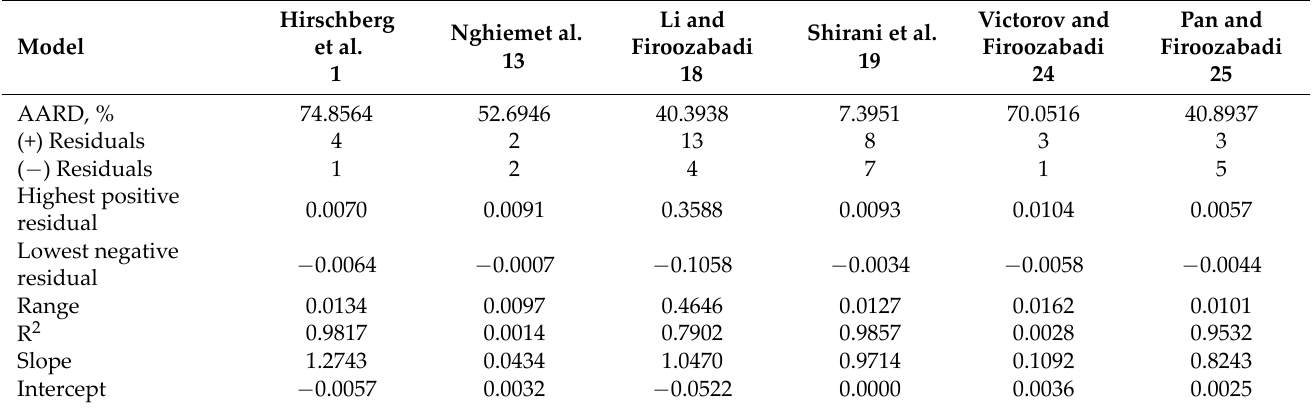
Table 6. Statistical analysis for models to calculate asphaltene precipitation by effects of pressure and